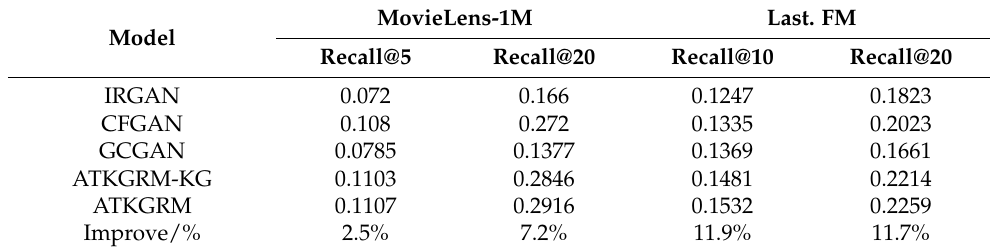
Table 5. Comparison results of adversarial training models. Model